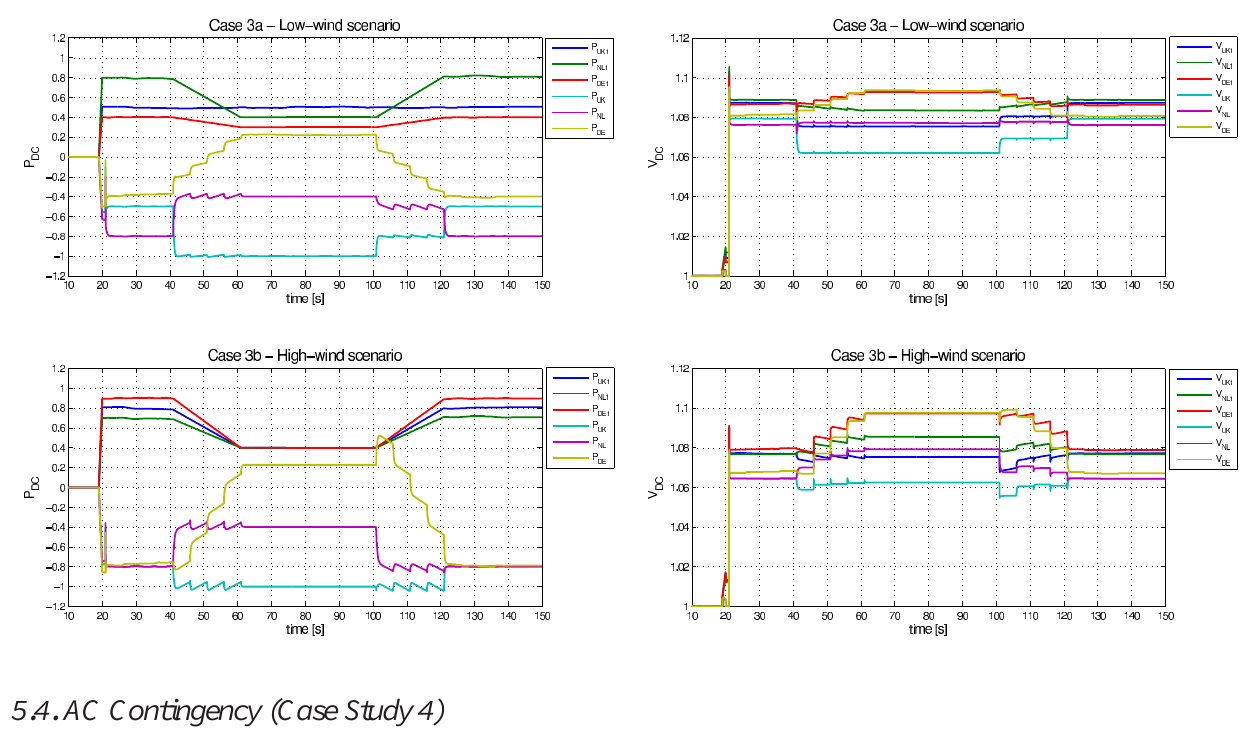
Figure 13. Results from Case Study 3: Wind